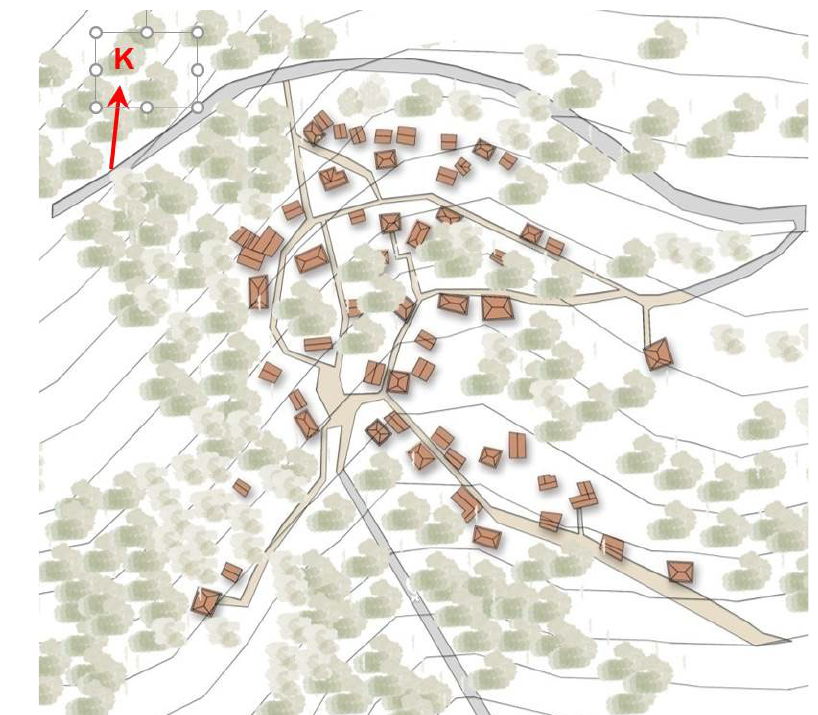
Figure 7 Kasımlar Village site plan (Keep Your Village Alive